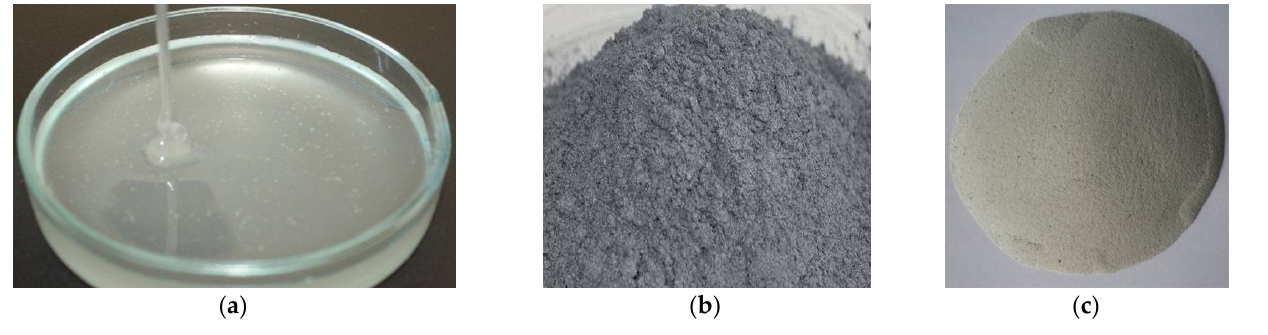
Figure 1. Appearance of raw materials used: ( a ) liquid glass; ( b ) fly ash, ( c ) aluminosilicate microsphere. Table 1. Chemical composition of the feedstock. Content of Oxides, % Liquid Glass Fly